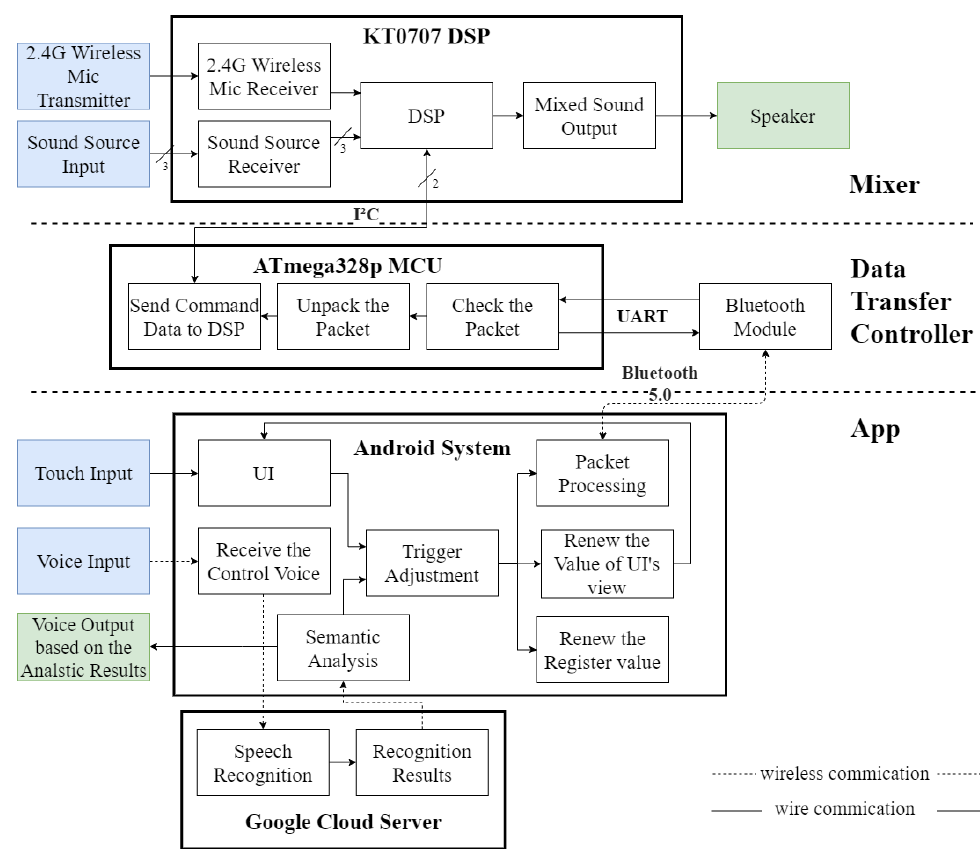
Figure 1. Proposed smart system platform designs for APP, DTC, and the mixer.